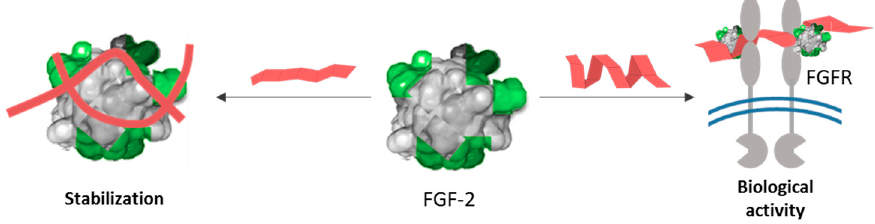
Figure 10. Dual function of chondroitin sulfates in their binding to FGF-2 as mediators of growth factor signaling to cells (right) or as providers of storage sites, protecting and stabilization the protein (left).